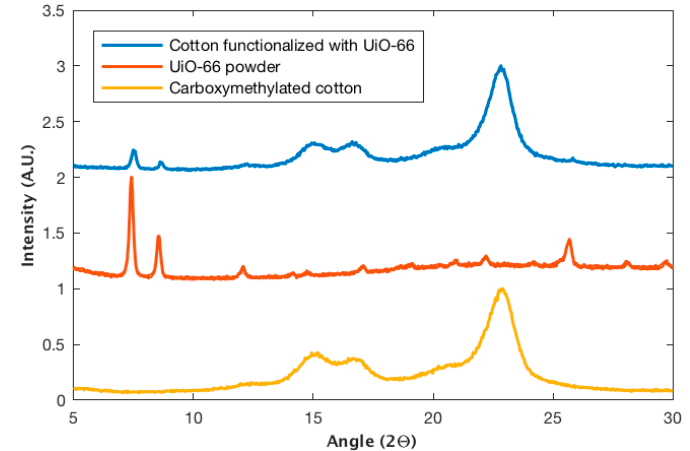
Figure 2. X-ray diffraction patterns for carboxymethylated cotton, UiO-66 powder, and cotton fabric functionalized with UiO-66.